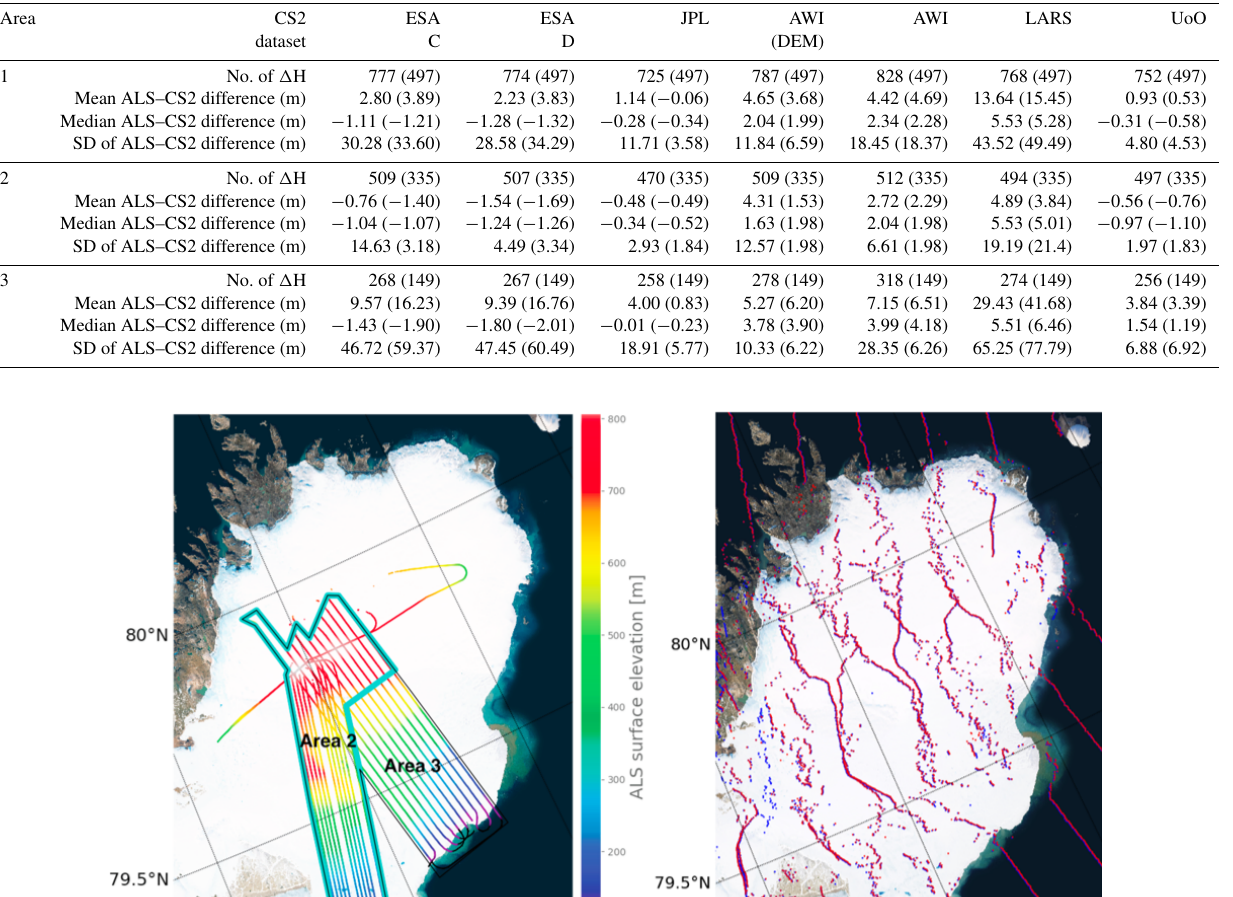
Table 2. Updated statistics in brackets for Sandberg Sørensen et al. (2018), with the inclusion of the new ESA Baseline-D L2 processing of CryoSat. The improvements of the new processing are especially noticeable in the standard deviation (SD) of observations in Area 2 (see Fig. 7).